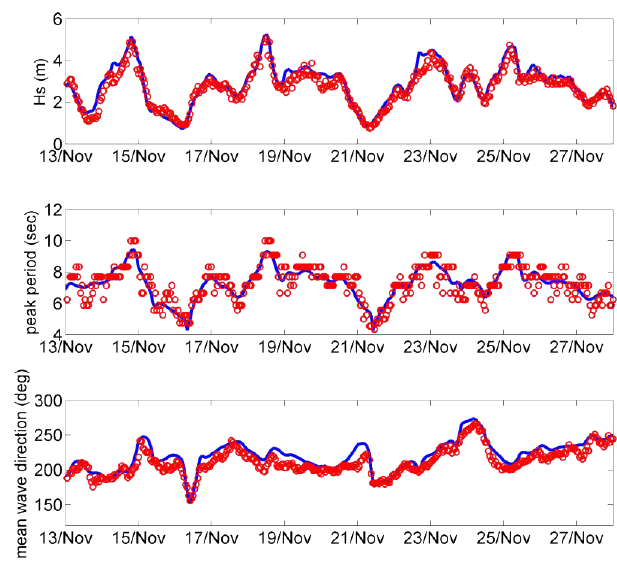
Figure 7. Time series of wave parameters: blue – model results; red circles – observations. Wave height (upper panel), peak period (middle), and mean wave direction (lower). Location: K13